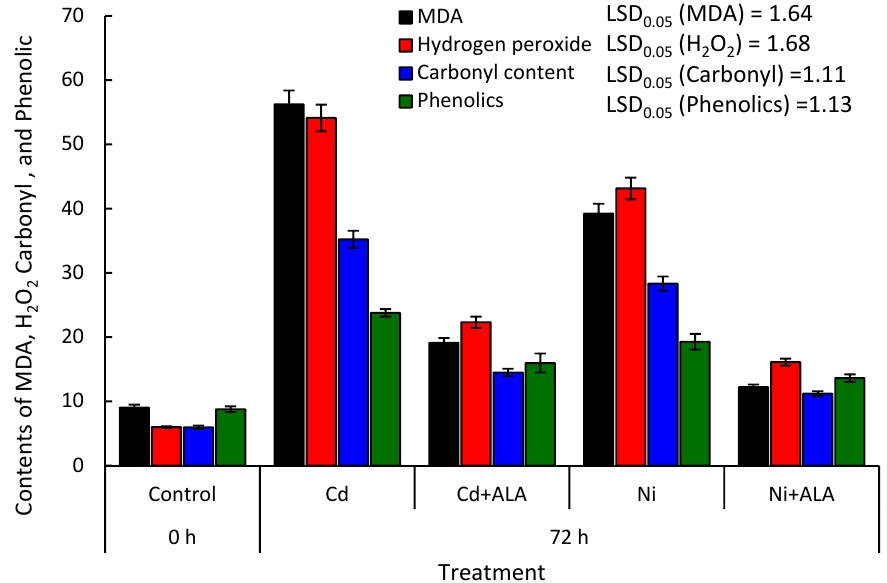
Figure 6. Contents of malondialdehyde (MDA, nmol mg − 1 FW), hydrogen peroxide (H 2 O 2 ) (nmol mg − 1 FW), protein carbonylation (nmol mg − 1 protein), and phenolic contents (mg GAE 100 g − 1 FW) in the leaves of P. sativum treated with heavy metals (100 µ M CdCl 2 or NiCl 2 ) or heavy metals coupled with 5-aminolevulinic acid (200 µ M ALA + 100 µ M heavy metal) at the beginning of the experiment (0 h) and at the end (72 h). Values are average of means ( n = 6 ) and the error bar is the standard error. LSD 0.05 is the least significant difference at the probability level of 0.05.